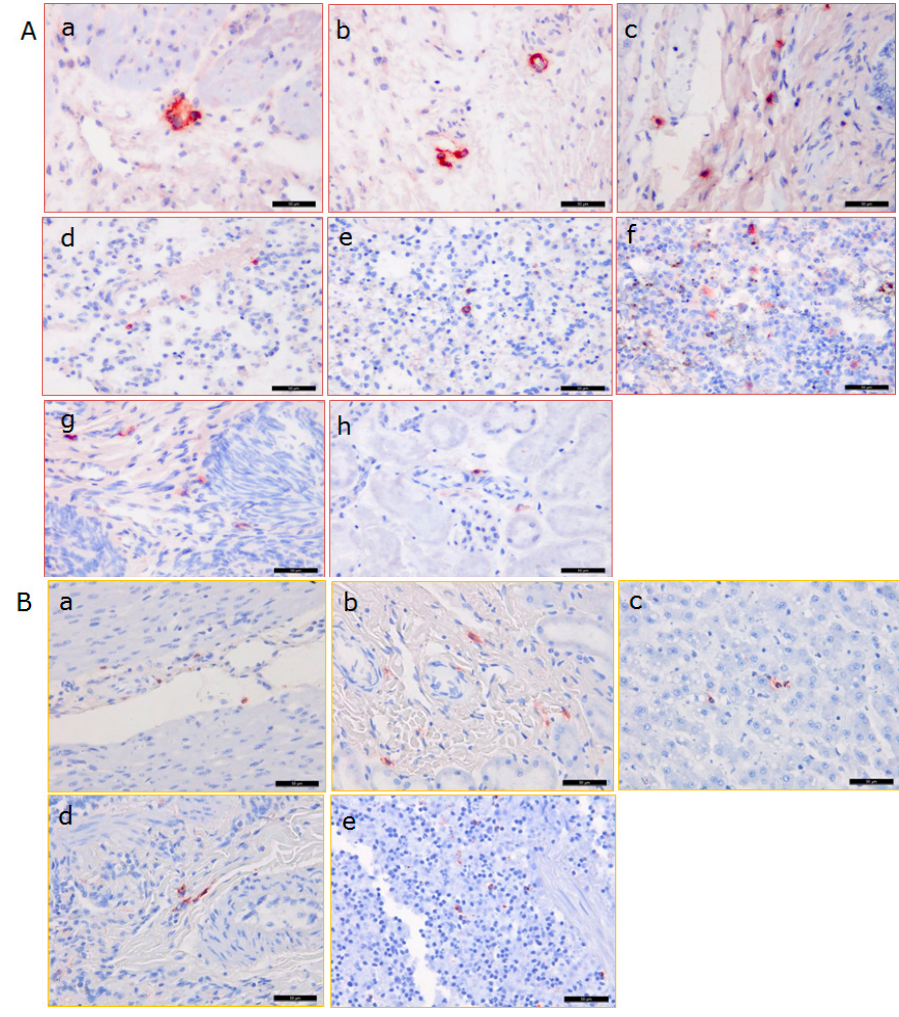
Figure 5. Immunohistochemical analysis of PCMV distribution in the pig donor heart, in different organs from baboon 57 ( A ) and from control baboon 43 ( B ). To detect PCMV, a specific rabbit serum